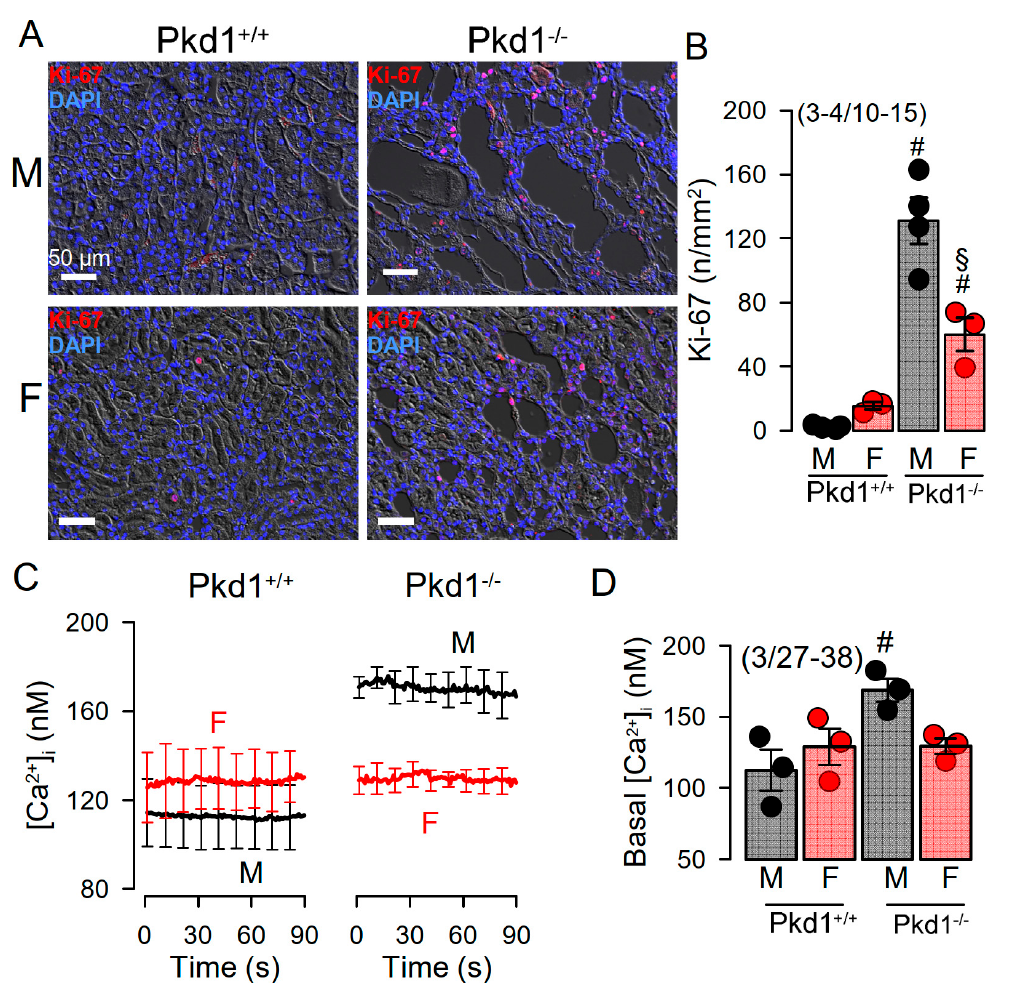
Figure 3. Cell proliferation and intracellular Ca 2+ concentrations in renal epithelial cells from Pkd1 +/+ and Pkd1 − / − mice. ( A ) Analysis of tubular epithelial cell proliferation in kidney sections from male and female Pkd1 +/+ and Pkd1 -/- mice as indicates by Ki-67 staining. Bars = 50 µm. ( B ) Summary of Ki-67 positive cells/mm 2 tissue area in kidneys from male and female Pkd1 +/+ and Pkd1 − / − mice. Bars = 50 µm. ( C , D ) Intracellular basal Ca 2+ concentrations ([Ca 2+ ] i ) as assessed by Fura2 indicates higher basal [Ca 2+ ]i I in male Pkd1 − / − mice. Mean ± SEM (number of animals/number of experiments in each series). # Significant difference when compared to Pkd1 +/+ ( p < 0.05; unpaired t-test). § Significant difference when compared to male ( p < 0.05; ANOVA and Tukey’s post-hoc test).